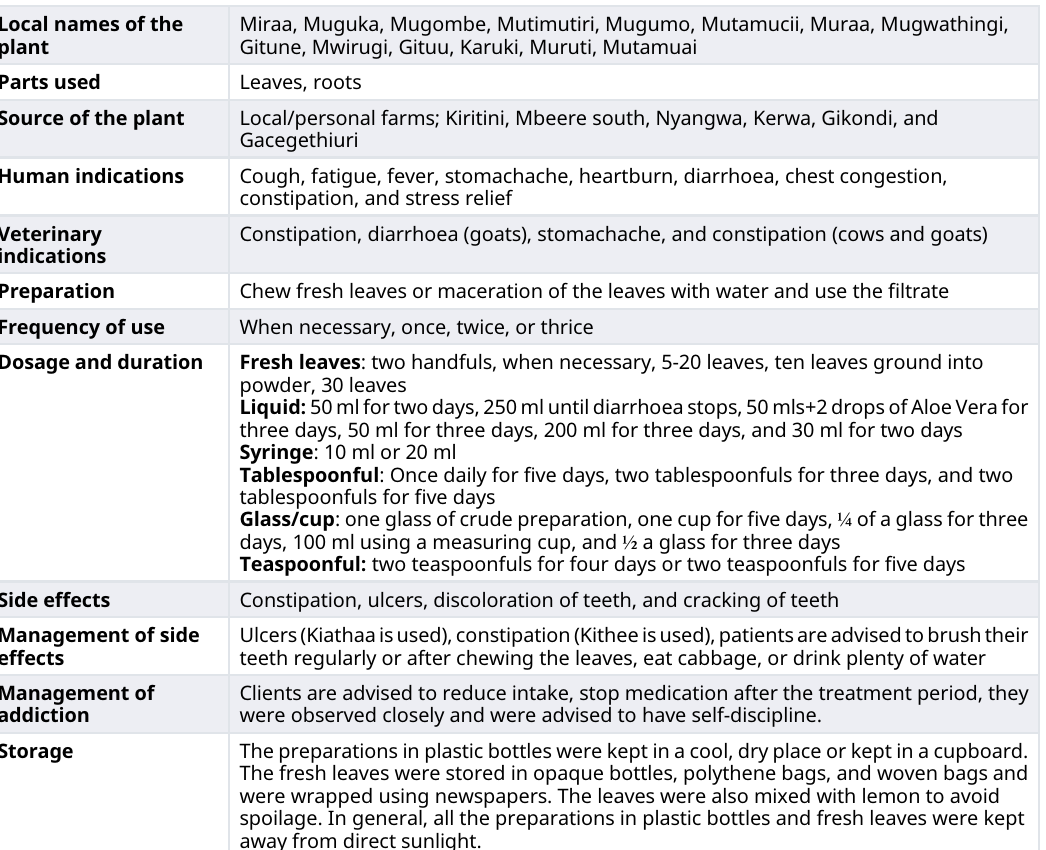
Table 5 summarizes the effect of varying doses of the aqueous extract of Catha edulis on various hematological parameters in female rats.